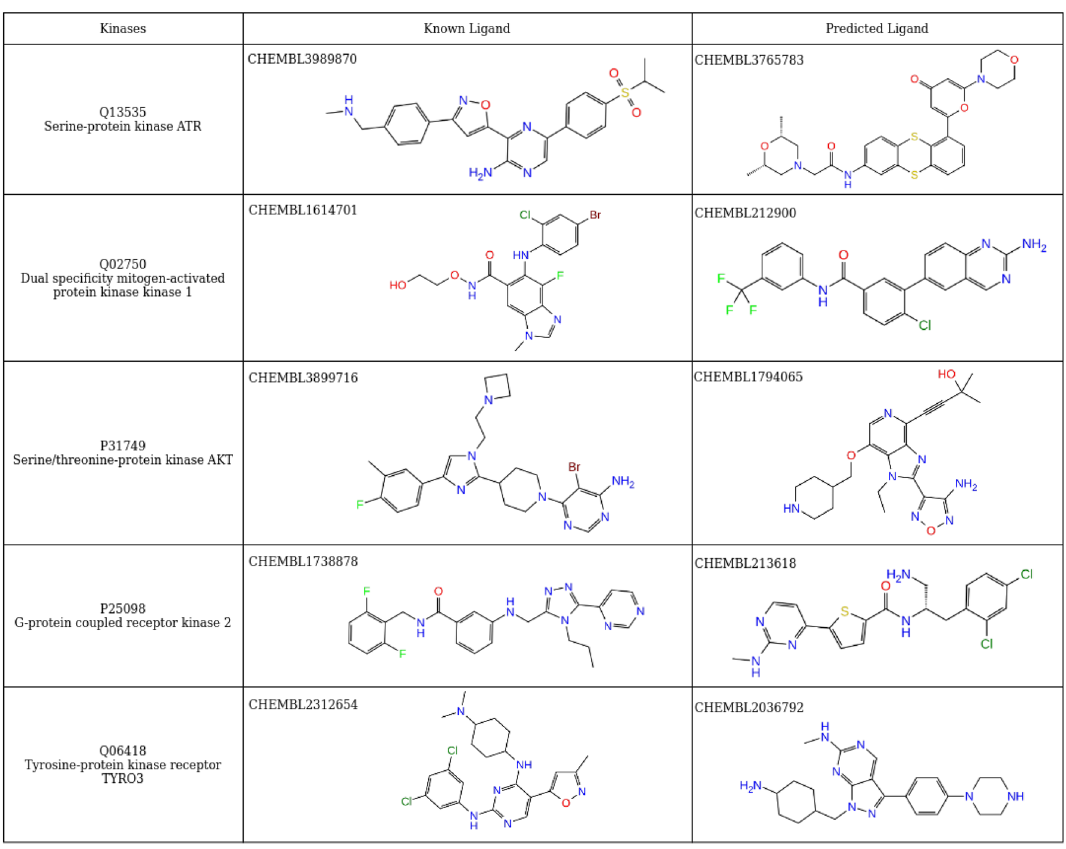
Table 1. Predicted and known actives for kinases. A comparison of the structures of predicted active ligands for kinases Q13535, Q02750, P31749, P25098, Q06418 and the structures of some of their known actives.